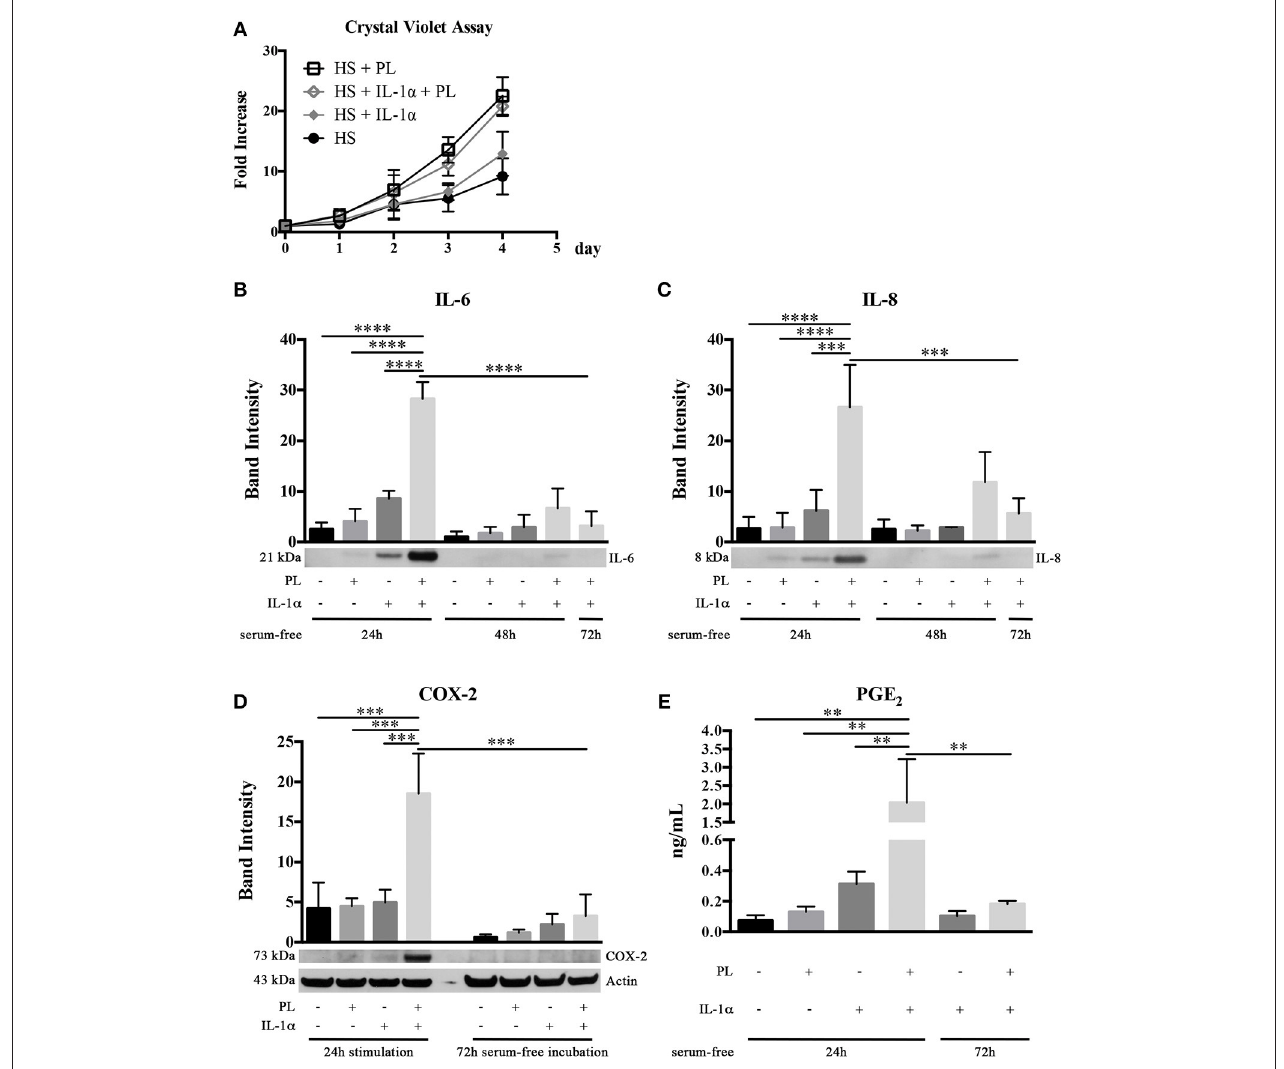
FIGURE 6 | Effect of PL on proliferation and inflammatory response of HS-expanded hASC at passage 2 within an inflammatory milieu. (A,B) Cell proliferation monitored by crystal violet staining assay in normal and inflammatory (i.e., in the presence of IL-1 α ) conditions for different times (A) ; (B,C) Secretion of IL-6 (B) and IL-8 (C) in hASC-conditioned media collected 24, 48, and 72h after 24-h PL stimulation, in presence or absence of IL-1 α . Densitometric analyses (means ± SD) of the western blots from 3 independent experiments and representative western blots (in the lower panels) are reported. The *** and **** symbols correspond to p = 0.0002 and p < 0.0001, respectively; (D) COX-2 production in hASC-cell lysates harvested after 24-h PL stimulation, in presence or absence of IL-1 α , and after further 72-h serum-free incubation. Densitometric analysis (means ± SD) of the western blots from 3 independent experiments and representative western blots (in the lower panels) are reported. Actin was used as internal control. The *** symbol corresponds to p ≤ 0.0009; (E) Quantification by ELISA of PGE 2 in hASC-conditioned media collected 24 and 72h after 24-h PL stimulation, in presence or absence of IL-1 α . Average values of 3 independent experiments performed in duplicate ± SD values are reported. The ** symbol refers to p ≤